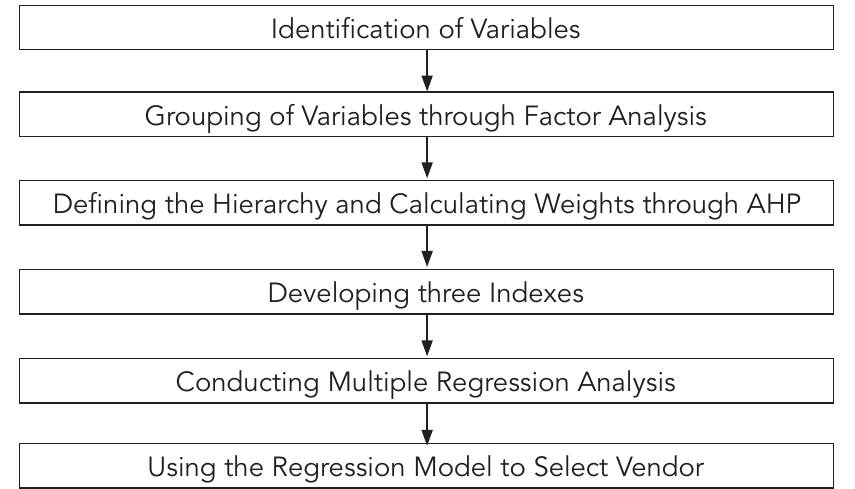
Figure 1: Schematic presentation of research